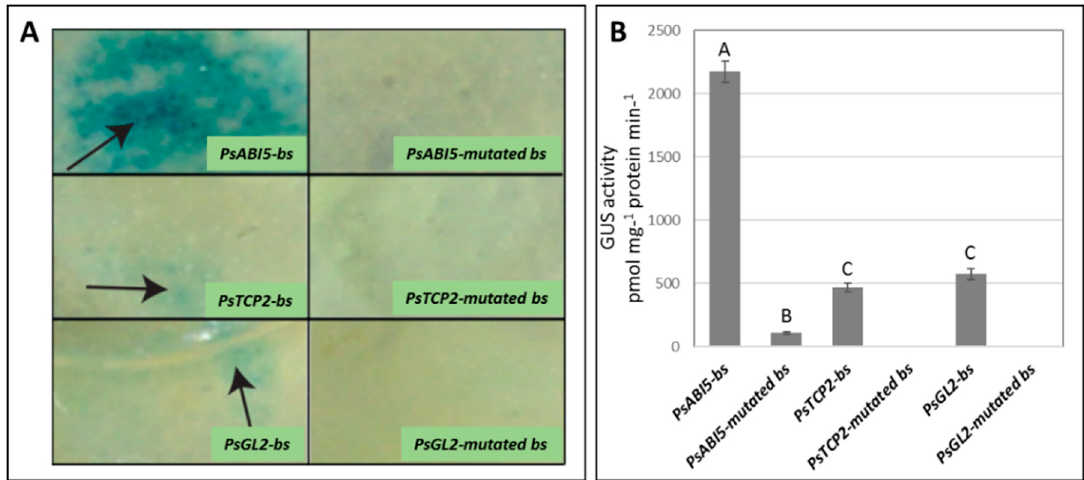
Figure 5. GUS activities generated by synthetic fragments containing tandem repeats of core promoter cis-elements and their corresponding mutated sequences (Table S1). The cis-acting elements are defined by the transcription factors bound to them, PsABI5-bs (binding site), PsTCP2-bs, and PsGL2-bs or their corresponding mutated forms, PsABi5-mutated bs , PsTCP2-mutated bs, and PsGL2 - mutated bs . Qualitative ( A ) and quantitative ( B ) GUS activities, 48 h following Agrobacterium infiltration. Values are the mean ± SE (n = 3). Di ff erent letters indicate significant di ff erence in Tukey–Kramer test ( p ≤ 0.05).